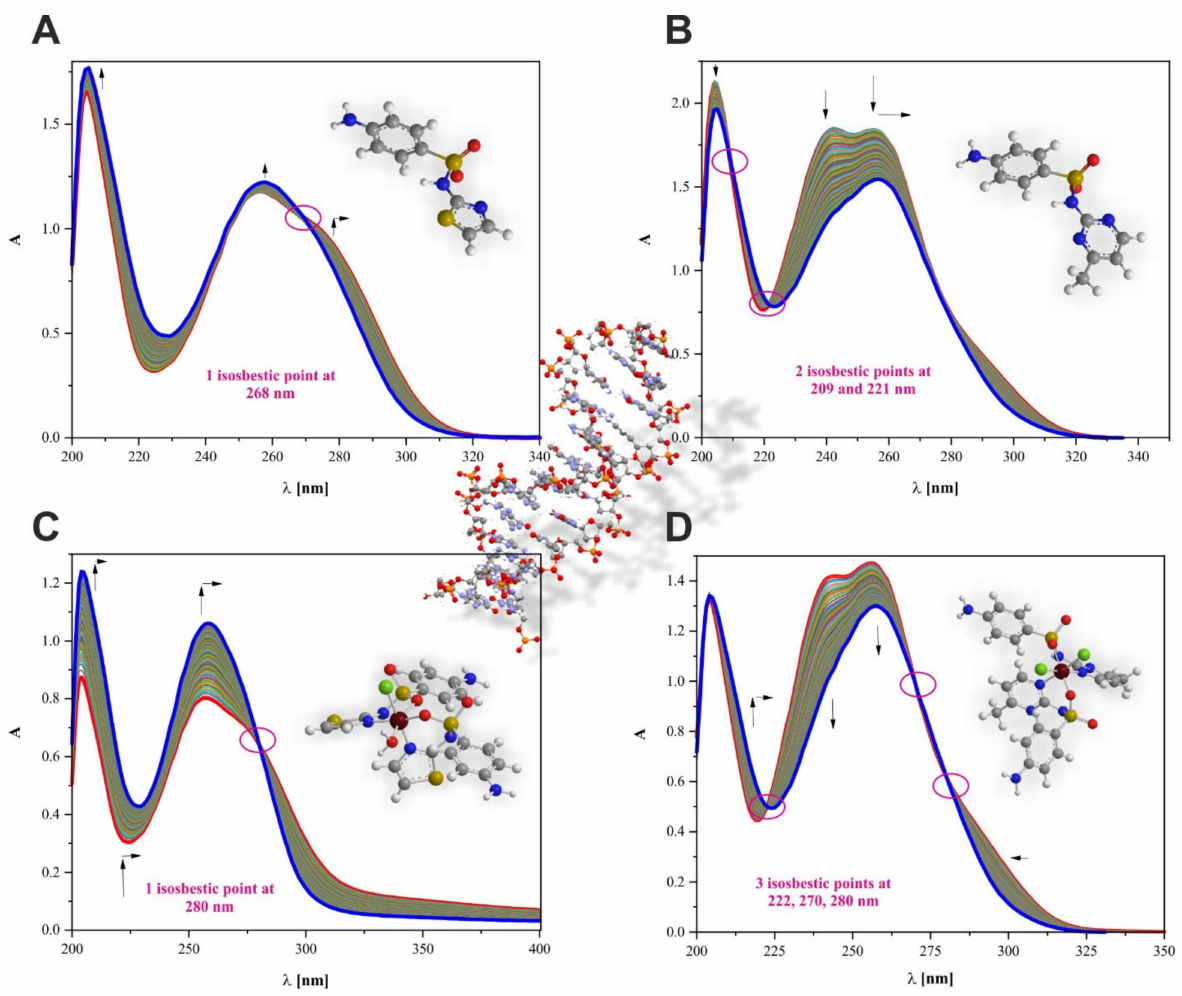
Figure 4. Changes observed in absorption spectra of ( A ) STZ (14 µ M), ( B ) SMZ (66 µ M), ( C ) [RuCl(OH 2 )(STZ) 2 ]Cl 2 · H 2 O (28 µ M), ( D ) [RuCl 2 (SMZ) 2 ]Cl (80 µ M) solutions. These spectra were registered in 5 mM Tris-HCl (50 mM NaCl) buffer pH 7.39 in the presence of different concentrations of DNA from 0–114 µ Mbp. The absorbance changes at selected wavelengths were included in Supplementary Materials Figure